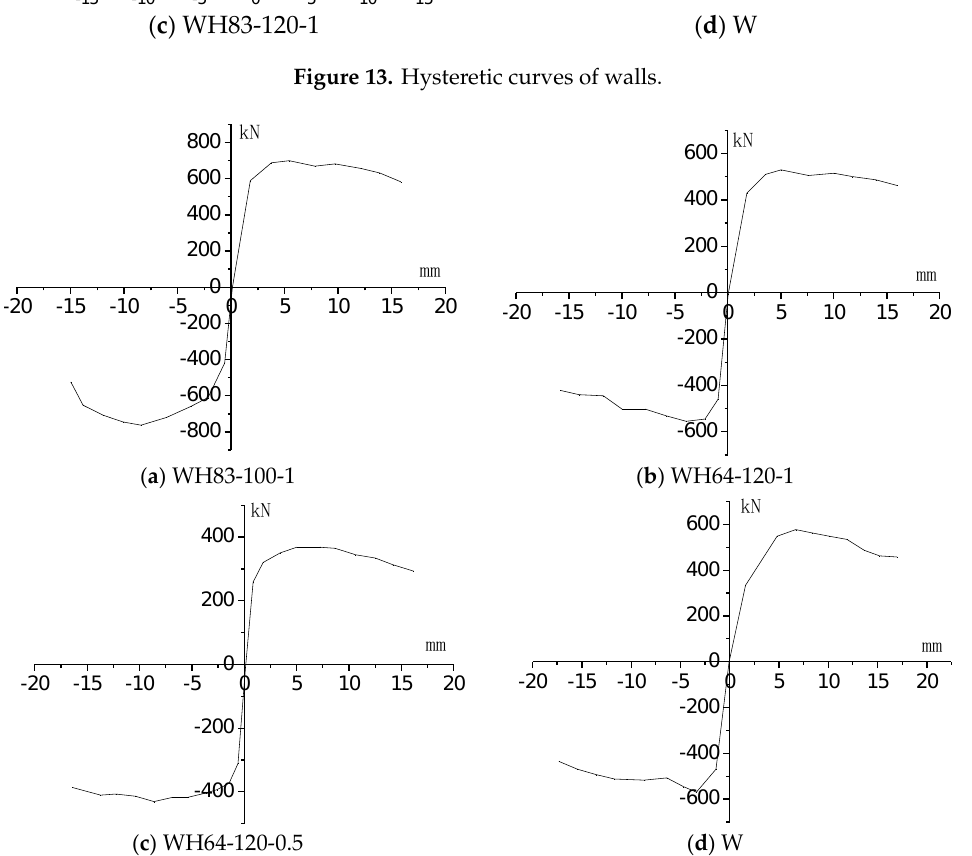
Figure 13. Hysteretic curves of walls.